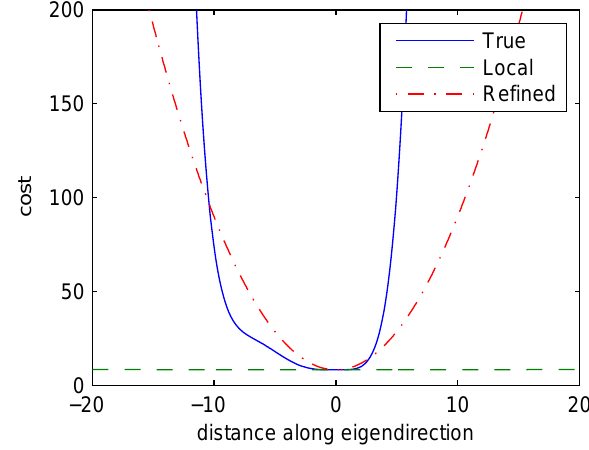
Fig. 5. Plots of the true cost function and its quadratic approxima- tions along a line in sample space. The direction of the line is paral- lel to the eigenvector of the Hessian 8 with the smallest eigenvalue, and the mode is translated to 0. The curvature of the local approxi- mation (dashed) is determined by the second derivative of the cost function at its minimum, while the curvature of the refined approxi- mation (dot-dashed) is adapted to better reflect the global properties of the cost